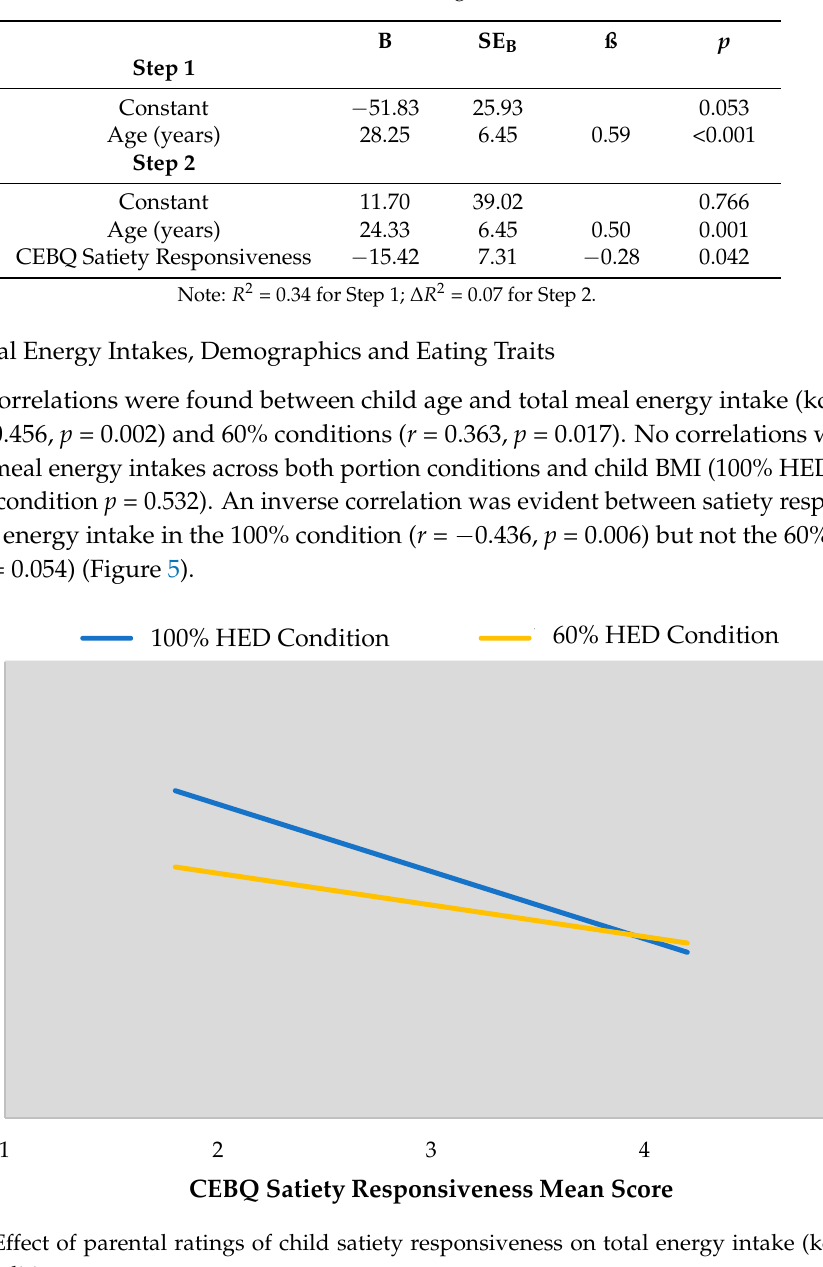
Table 4. 100% HED intake regression model.